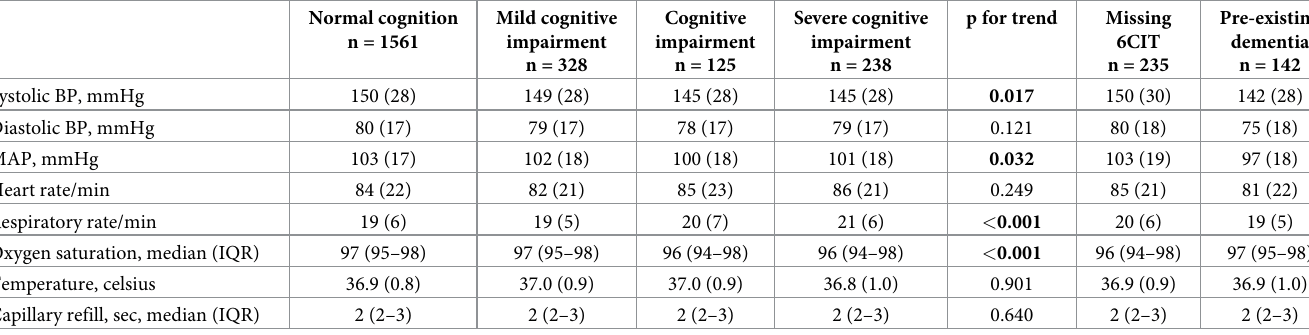
Table 2. Vital signs over strata of cognitive function in older patients in the ED.